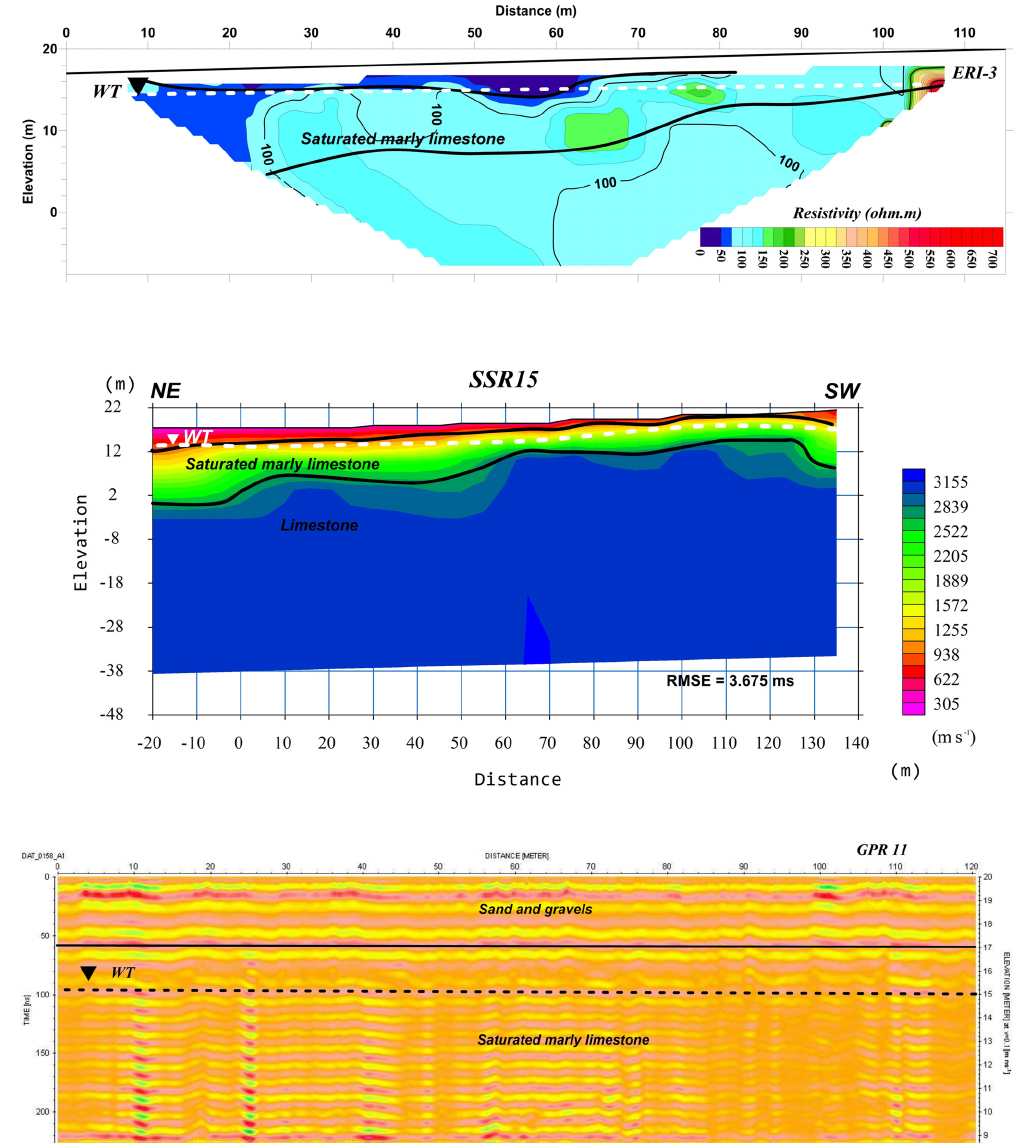
Figure 8. ERI, SSR, and GPR profiles in the tomb of Queen